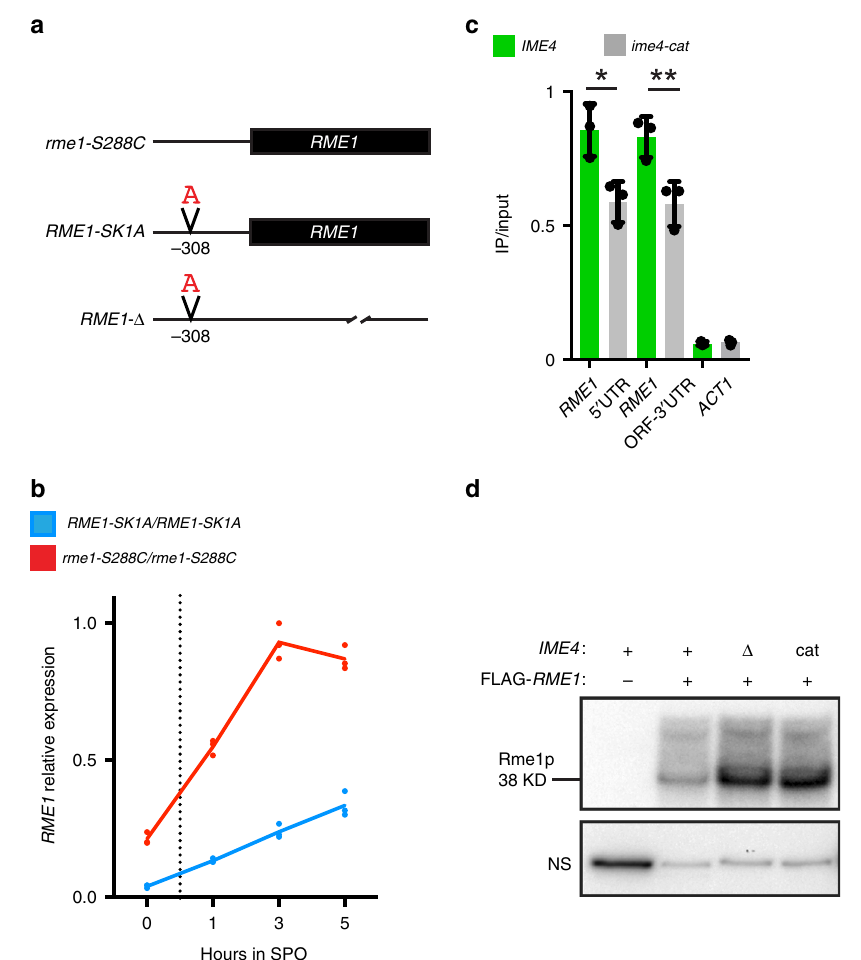
Fig. 1 RME1 alleles in this study. IME4 downregulates Rme1p through its m 6 A activity. a The three RME1 alleles are in the SK288C strain background. RME1- SK1A has a single A insertion 308 nucleotide upstream of the open reading frame (ORF) relative to rme1-S288C . b Quantitative reverse transcription PCR (RT-qPCR) quanti fi cation of RME1-SK1A and rme1-S288C expression during meiosis. Means and individual values from three biological replicates. Source data are provided in a Source Data fi le. c m 6 A immunoprecipitation (IP) followed by RT-qPCR using RME1 5 ′ untranslated region (UTR) primers or primers that span the end of the ORF and the 3 ′ UTR on mRNA isolated from IME4 and ime4-cat homozygous cells, both in rme1-S288C homozygous cells. Transcript levels were fi rst normalized to PGK1 as an internal control, and then the fold enrichment of IP/input was calculated. The residual enrichment of RME1 transcripts in ime4-cat / ime4-cat cells relative to IME4 / IME4 cells probably results from non-speci fi c binding to the anti-m 6 A antibody 13,23 . ACT1 serves as a non-methylated control. Means, individual values, and s.d. from three biological replicates. * p = 0.022, ** p = 0.019, two-tailed t test. Source data are provided in a Source Data fi le. d Western blot using anti-FLAG antibody showing Rme1p expression from the rme1-S288C allele in strains homozygous for the indicated allelic backgrounds incubated in SPO media for 5 h. A non-speci fi c (NS) band present in all lanes serves as a loading control. Source data are provided in a Source Data fi